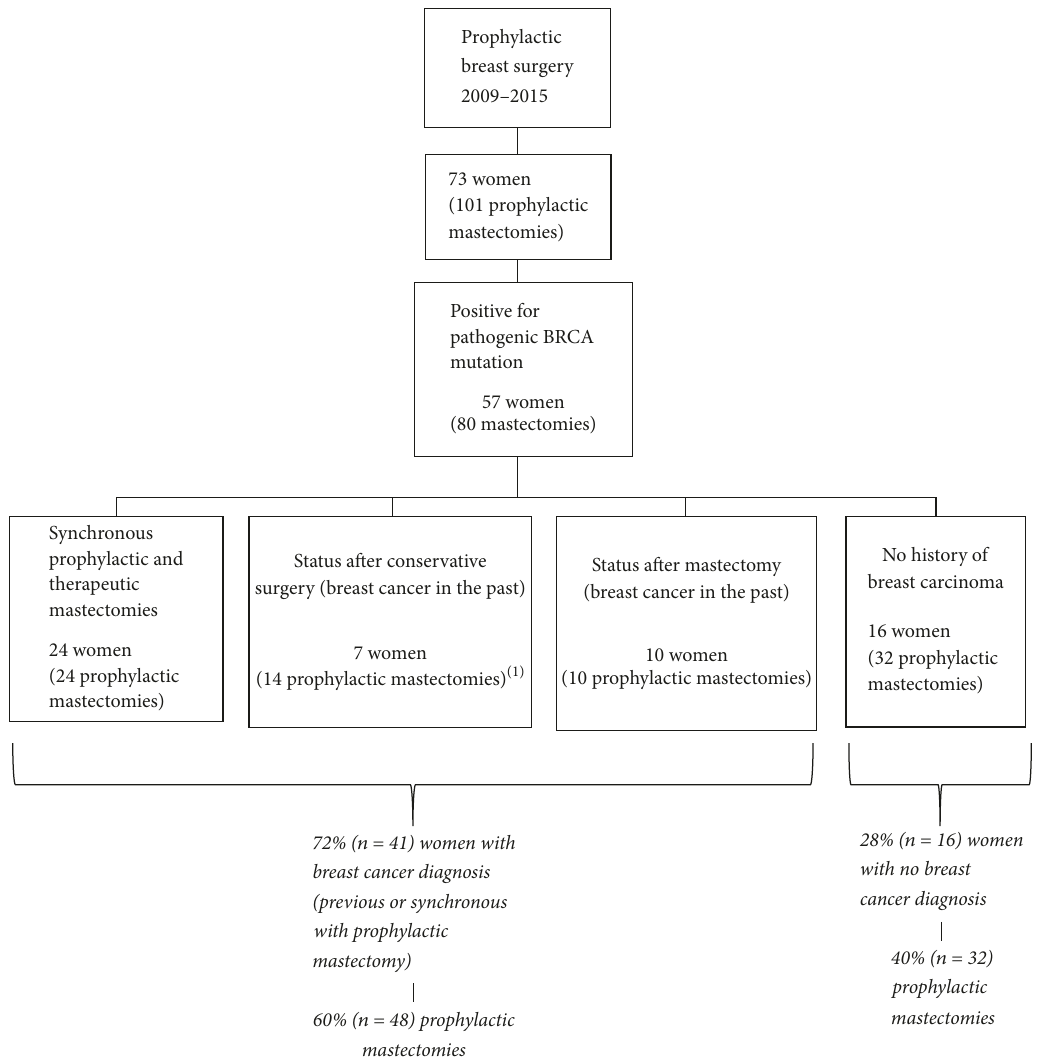
Figure 1: Patients admitted to prophylactic breast surgery ( (1) including prophylactic mastectomy of the remnant breast).